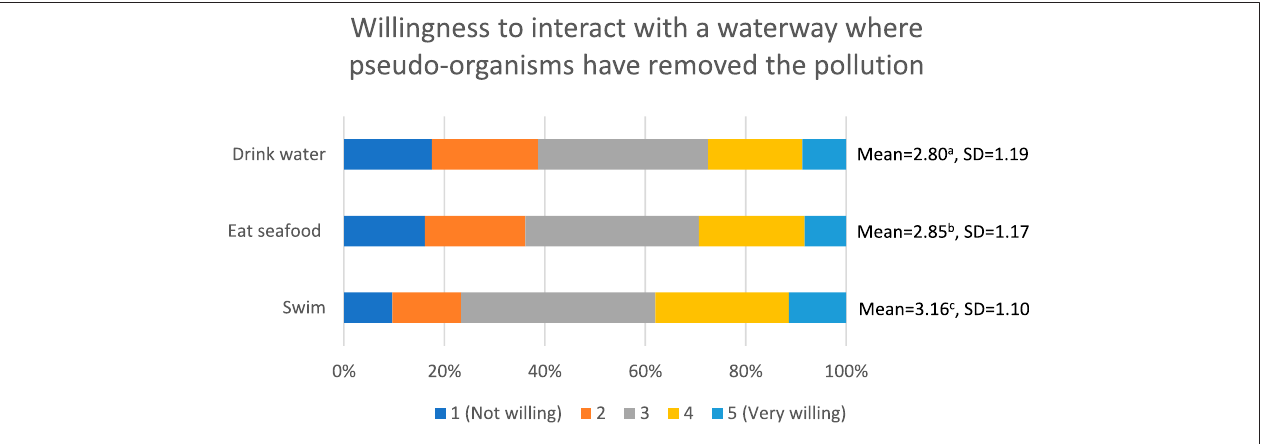
FIGURE 7 | Willingness to drink water, eat seafood or swim in a waterway where the technology has been used to remove the pollution. Notes: Different superscripts (a, b, and c) denote statistically signi fi cant differences between the means.